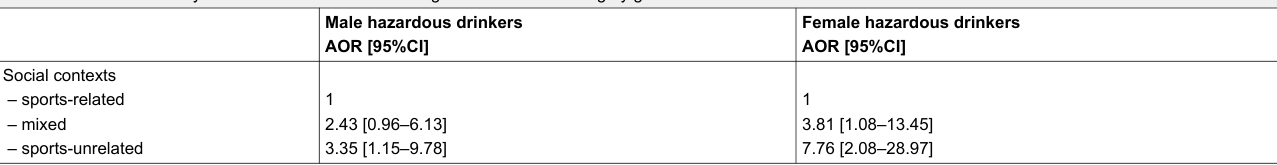
Table 2: Multivariate analysis a of social contexts according to hazardous drinking by